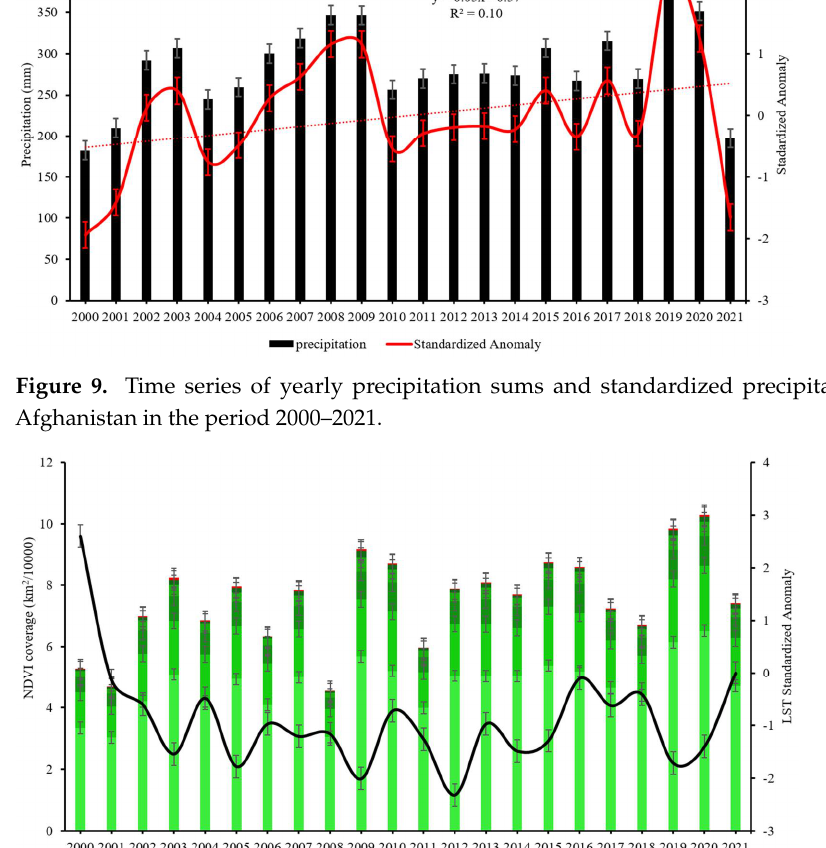
Figure 10. The relationship between time series of yearly vegetation coverage variations and stand- ardized LST anomaly in Afghanistan in the period 2000–2021.